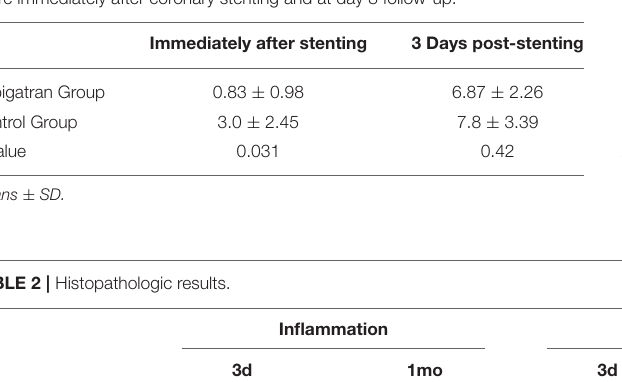
TABLE 1 | Optical coherence tomography (OCT) results of the tissue burden score immediately after coronary stenting and at day 3 follow-up.